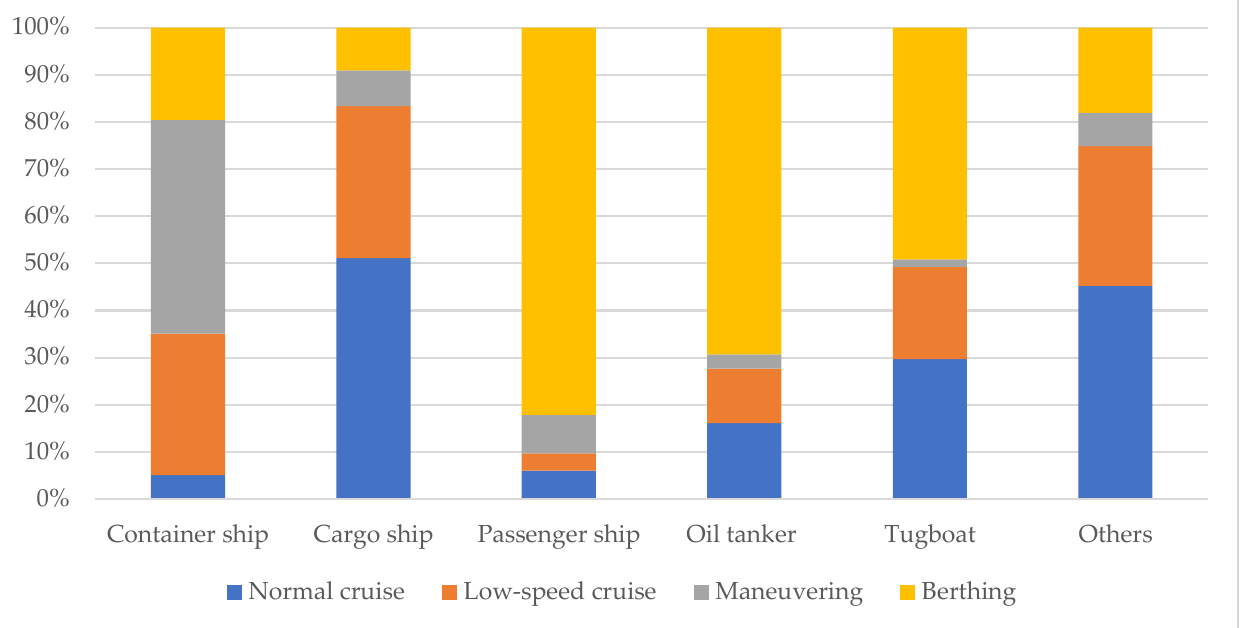
Figure 12. Comparison of NO X emissions in different sailing states.